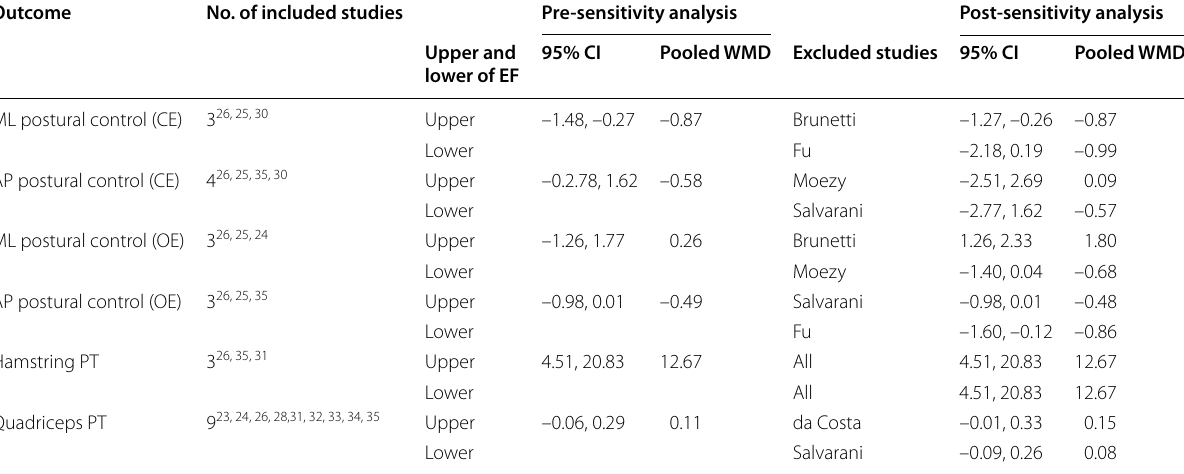
PT peak torque, AP anterioposterior, ML mediolateral, CE closed-eye, OE open-eye